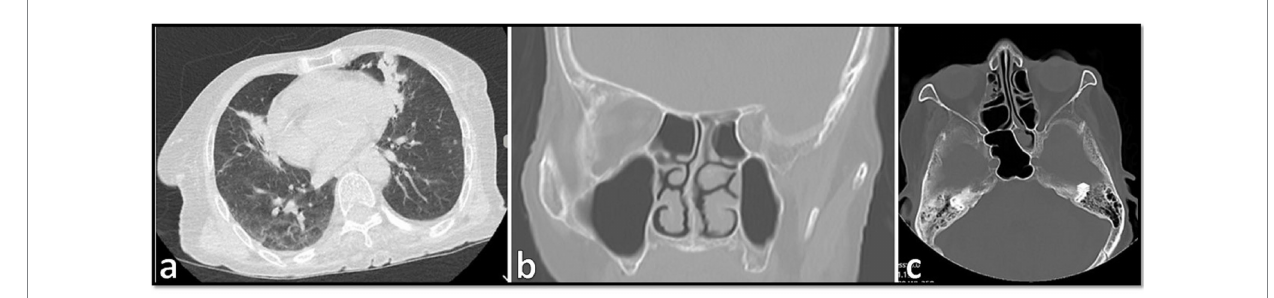
FIGURE 1 (A) Computed tomography scan of the chest in the case showing bilateral ground-glass opacities with a predominantly peripheral and multilobar location. (B,C) Orbital computed tomography scans of paranasal sinuses demonstrating opacification and air-fluid level in the left sphenoid sinus and some anterior ethmoid sinus air cells in right septal deviation to the right mucosal thickening in the left maxillary sinus.